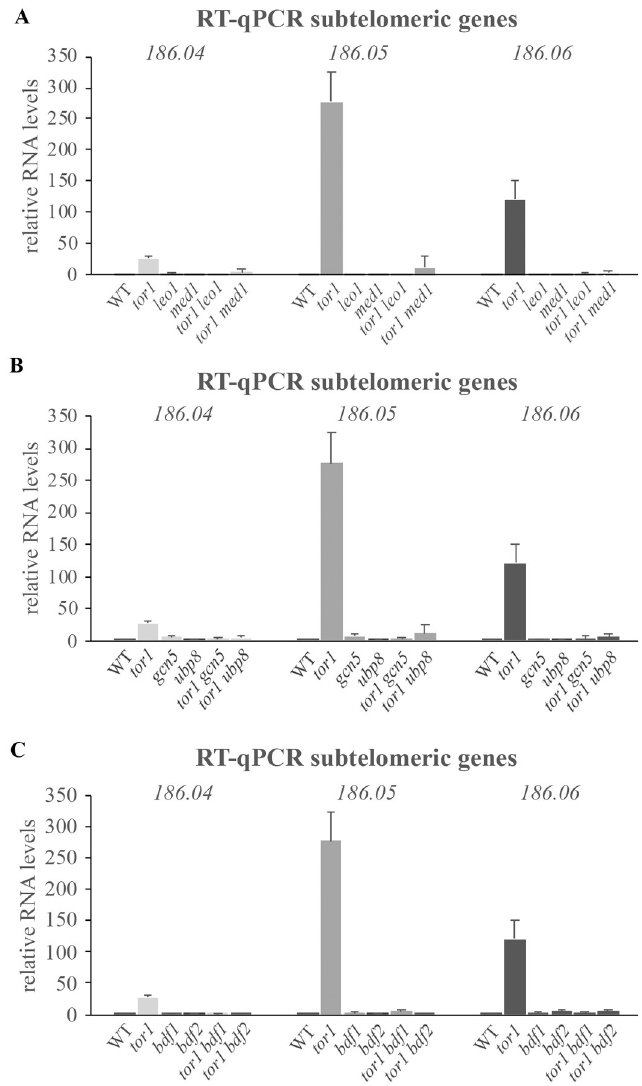
Fig 2. Suppression of the silencing defect in TORC2 mutant cells. Loss of Leo1 or Med1 ( A ), Gcn5 or Ubp8 ( B ) and Bdf1 or Bdf2 ( C ) suppresses the silencing defect of Δ tor1 cells at subtelomeric genes. Expression levels of 3 subtelomeric genes, spac186 . 04 , spac186 . 05 and spac186 . 06 were determined by RT-qPCR in wild type (WT) and the indicated deletion mutant cells. The level of act1 + mRNA was used as a reference. Each value is the mean of at least three independent assays and the error bars indicate standard